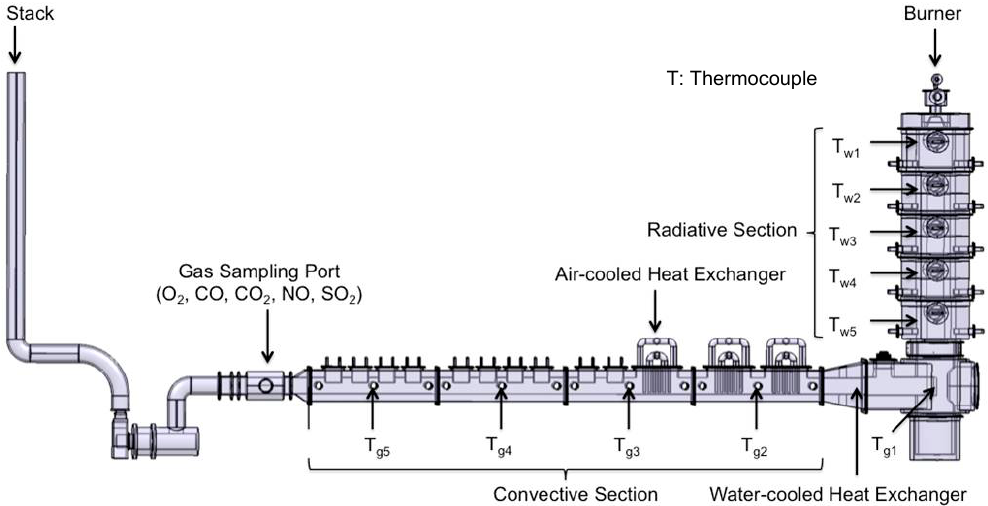
Figure 2. Schematic of the 300-kW th multi-fuel combustion system.